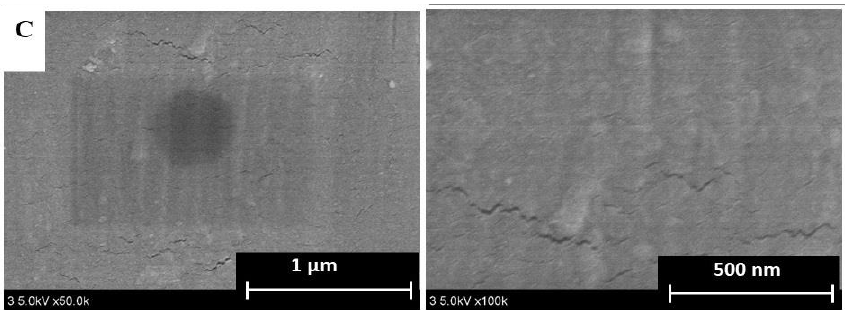
Figure 16. SEM micrographs of the ( A ) drawn salt-confined nylon 6,6 DR 5.5 HT 140 °C, ( B ) regenerated and ( C ) stabilized nylon 6,6 fibres.